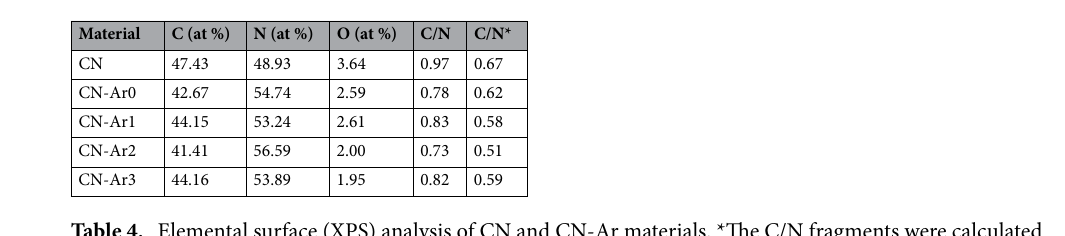
Table 4. Elemental surface (XPS) analysis of CN and CN-Ar materials. *The C/N fragments were calculated using only sp 2 C at 288.3 eV.